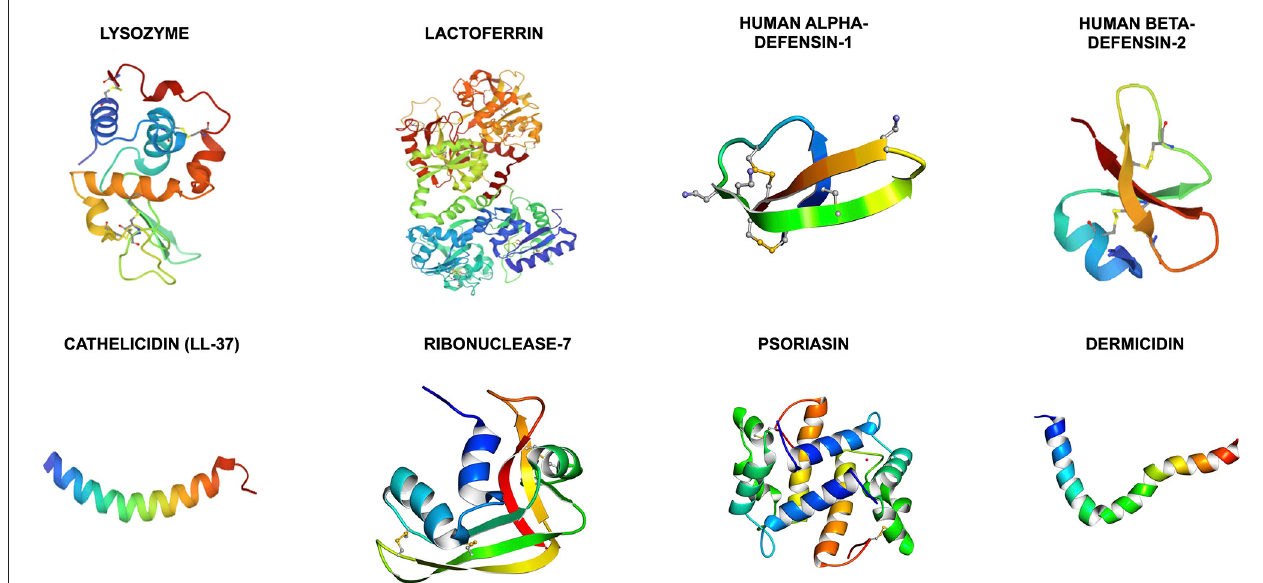
FIGURE 1 | Illustrations of the 3-dimensional secondary structures of the important host defense peptides (HDPs) at the ocular surface. The structures are obtained from the RCSB Protein Data Bank. Cathelicidin, psoriasin, and dermcidin are primarily made of alpha-helical helixes whereas human alpha- and beta-defensins are composed of triple beta-sheets. Lysozyme, lactoferrin and ribonuclease-7 (or RNase-7) are made of mixed alpha-helixes and beta-sheets.